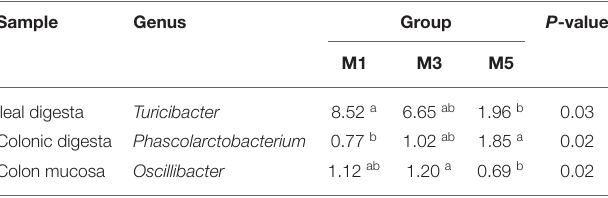
TABLE 2 | Relative abundance of microbial genera (percentage) significantly affected by feeding regimen in the ileal digesta, colonic digesta, and colon mucosa of pigs 1